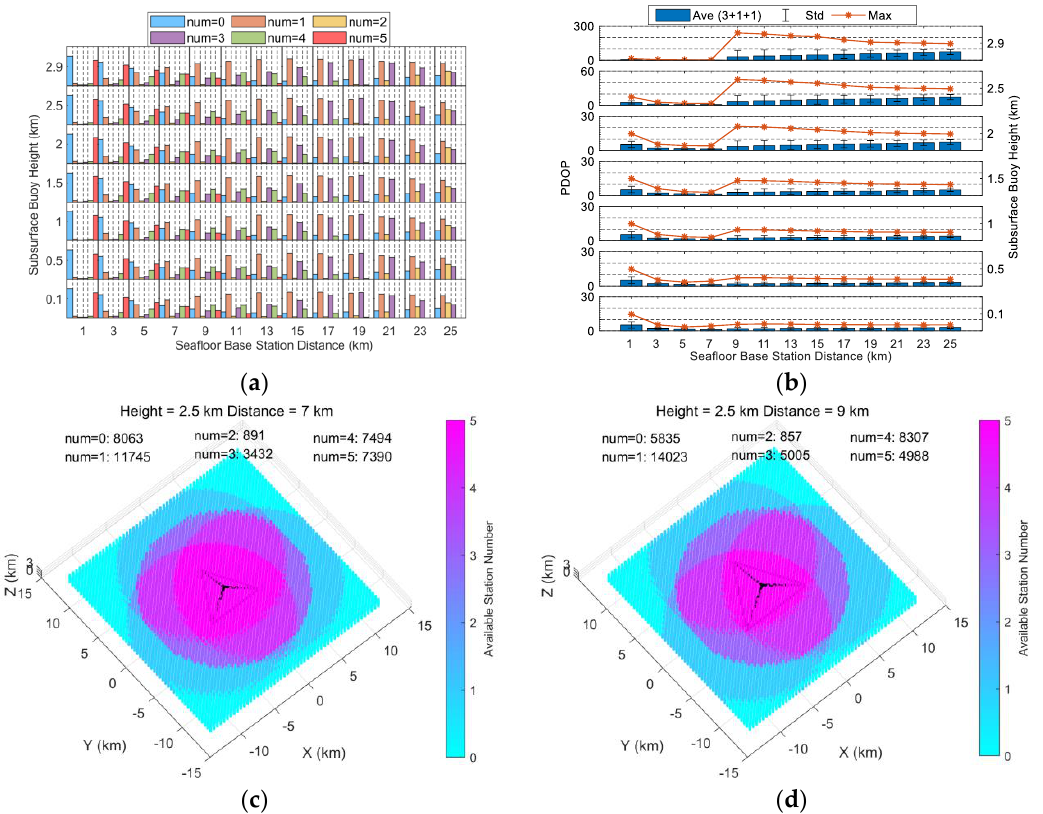
Figure 3. User positioning indicators under various distance and height conditions. ( a ) EPG with various available stations—the colors blue, orange, yellow, purple, green, and red indicate the available station numbers of 0~5, respectively; ( b ) changes in the average, standard deviation, and maximum of PDOP—the blue box denotes the average, the black vertical line denotes the standard deviation, and the orange asterisk line denotes the maximum value; ( c , d ) spatial distribution of the ASN when the subsurface buoy height is 2.5 km, and the seafloor base station distances are 7 km and 9 km, respectively.